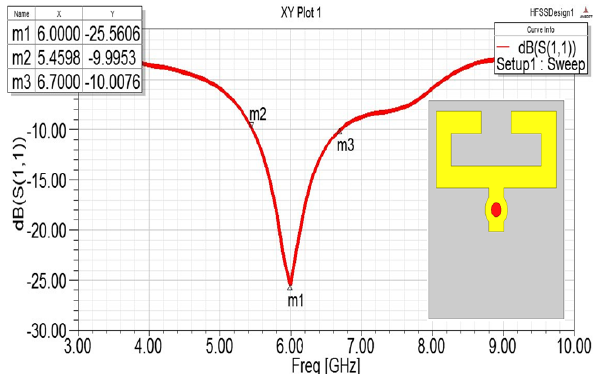
Figure 6. Reflection coefficient (S 11 ) of configuration